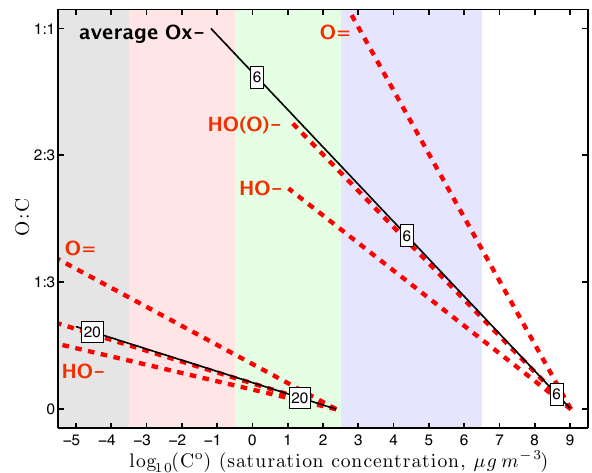
Fig. 2. The effect of different functional groups on volatility ( C o at 300K) and O:C for a C 6 and C 20 backbone. HO- is highly polar, decreasing C o by 2.3 decades per oxygen, leading to the shallow lines. O= is less polar, decreasing C o by 1 decade per oxygen, lead- ing to steeper lines. Acids (HO(O)-) decrease C o by 1.75 decades per oxygen. The average effect of oxygenated functionality deduced in this work (in black) leads to slopes similar to the organic